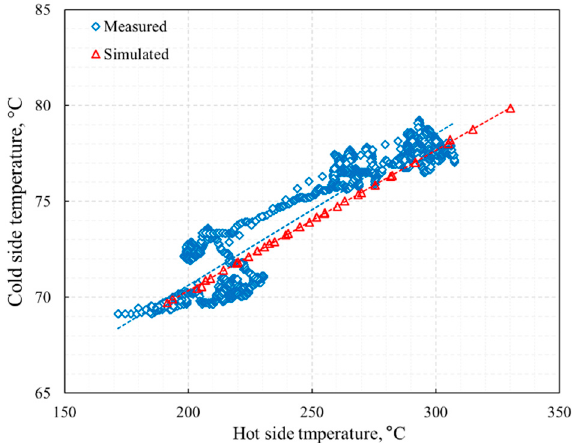
Figure 7. Comparison of simulated hot- and cold-side temperatures of TEG module with measured